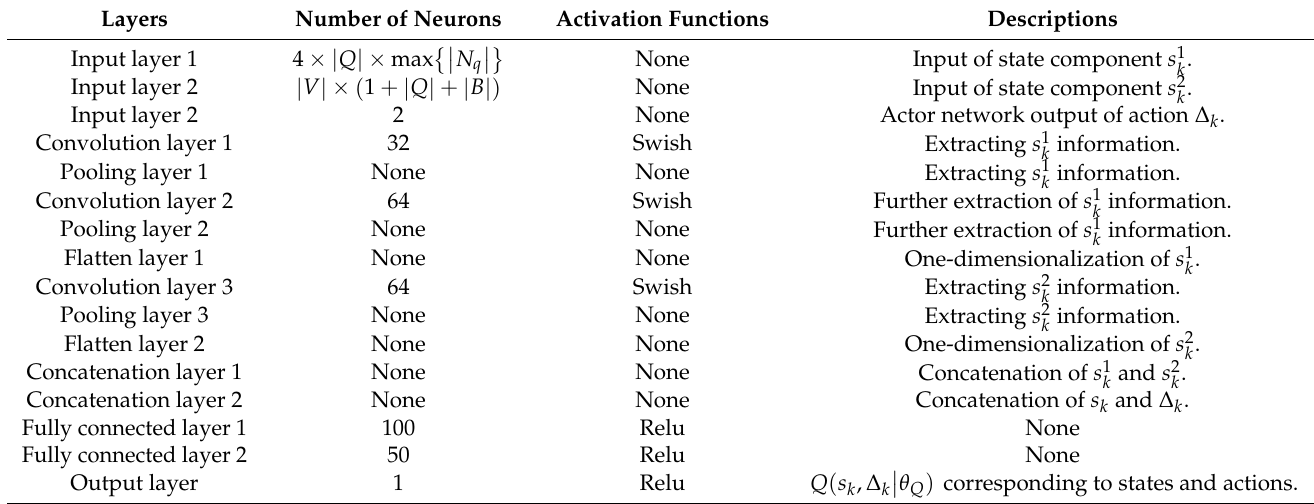
Table 5. Details of the Critic network